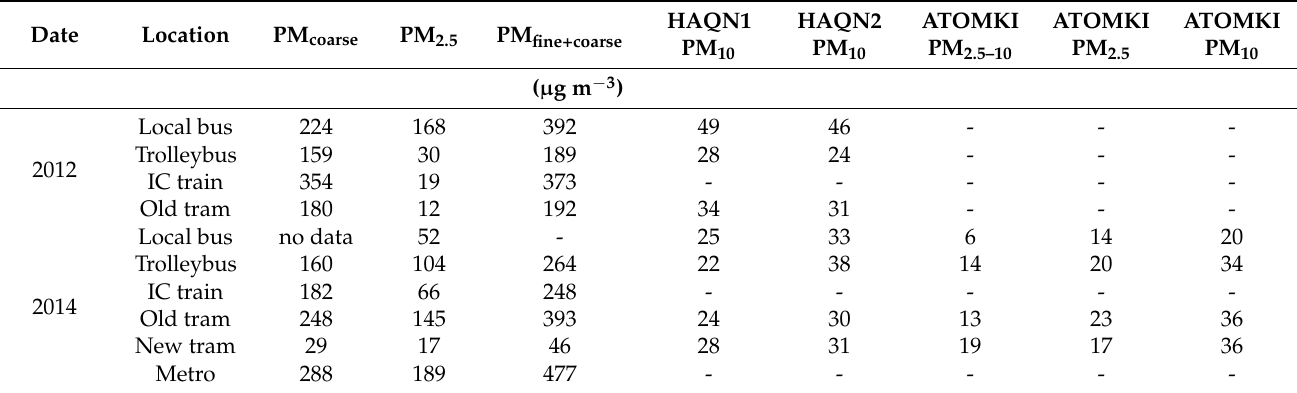
Table 2. The PM fine+coarse , PM 2.5 , and PM coarse concentrations (in µ g m − 3 ) in different vehicles and PM 10 concentrations measured at two automatic measurement stations of the HAQN in Debrecen: HAQN 1 (urban background) and HAQN 2 (urban